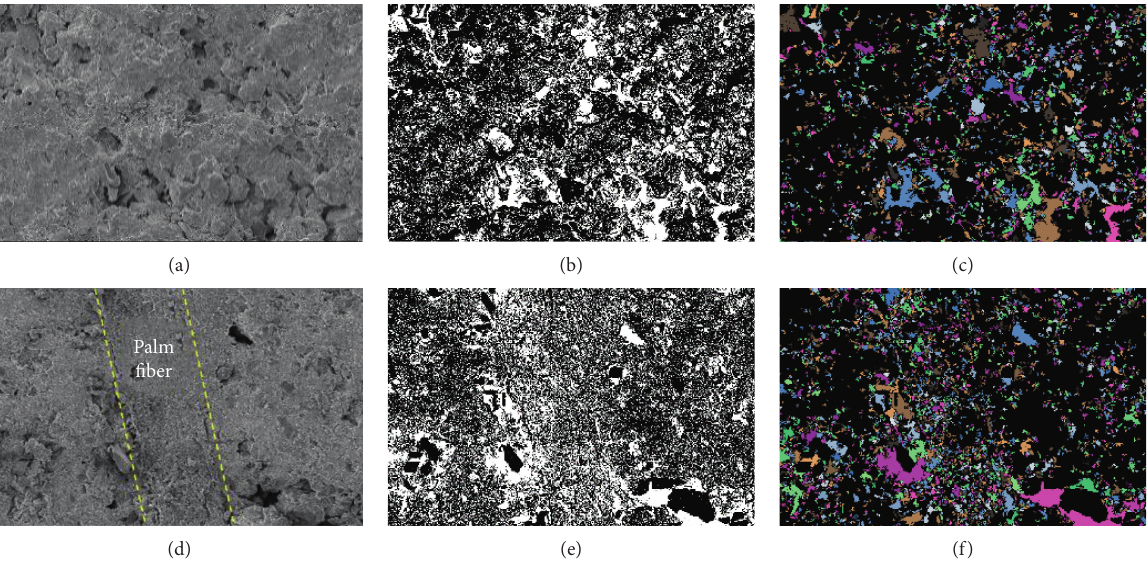
Figure 9: SEM images of unreinforced and reinforced soil before loading. SEM images of unreinforced soil: (a) original; (b) with binary image processing; and (c) with vectorization. SEM images of 0.6% reinforced soil: (d) original; (e) with binary image processing; and (f) with